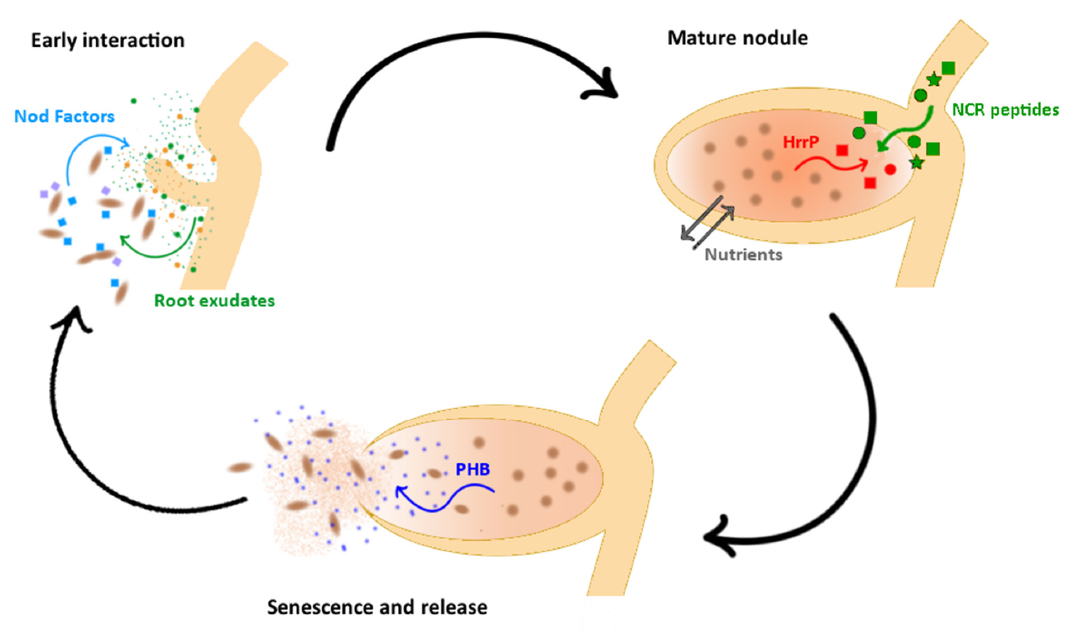
Figure 1. Genotype × genotype (G × G) interactions in the nitrogen-fixing root nodule symbiosis. A schematic example of three phases of symbiosis, namely, early interaction with roots, mature nodules and release of bacteria from dehiscent nodules, is shown. The key molecular actors identified along the phases are reported.